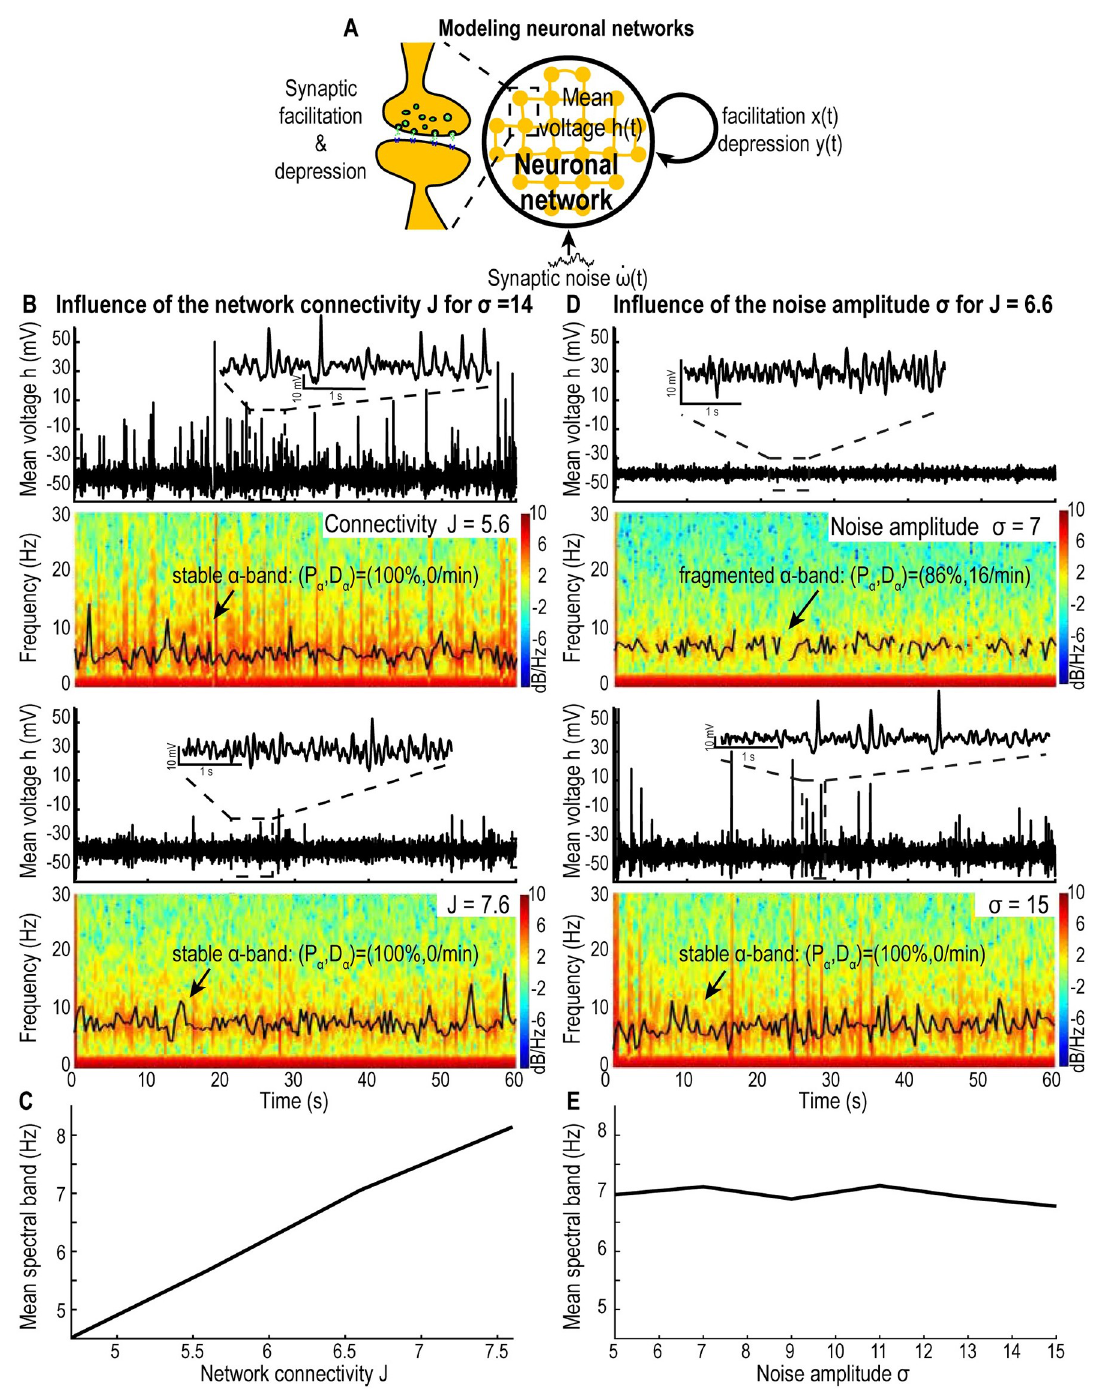
Fig 2. Effect of network connectivity J and noise amplitude σ on model (3) without AHP. A: Schematic of the facilitation-depression model (3). B: Time-series and spectrograms of h (60s simulations) with peak value of the dominant oscillatory band (black curve) for J = 5.6 (upper) and 7.6 (lower). C: Mean value of the dominant oscillatory frequency for J 2 [4.8, 7.8]. D: Time-series and spectrograms of h (60s simulations) peak value of the dominant oscillatory band (black curve) for σ = 7 (upper) and 15 (lower). E: Mean value of the dominant oscillatory frequency for σ 2 [5, 15]. Synaptic plasticity timescales: τ = 0.01s, τ r = 0.2s and τ f = 0.12 s .